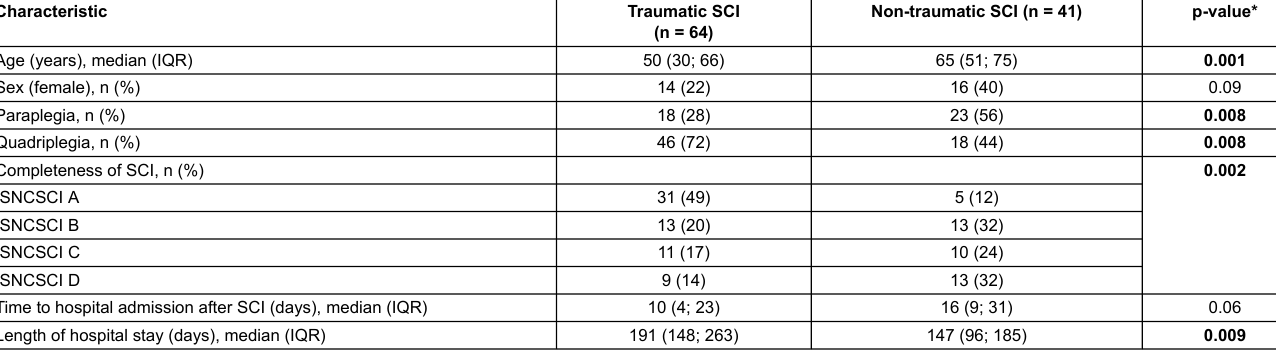
Table 2: Baseline characteristics – traumatic versus non-traumatic spinal cord injury.